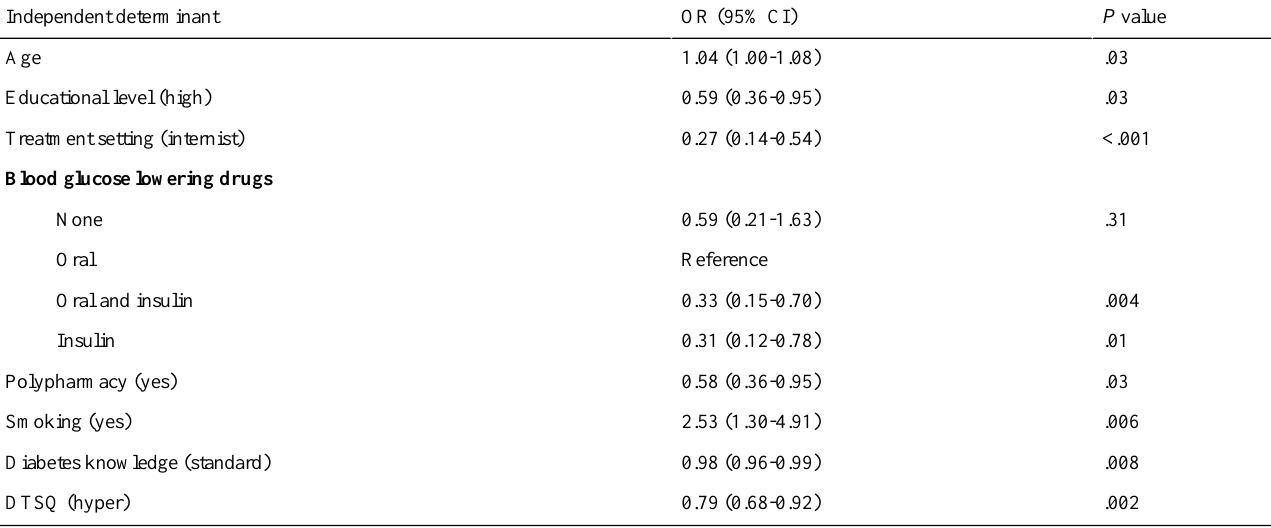
Table 2. Independent determinants of nonusers compared to users.